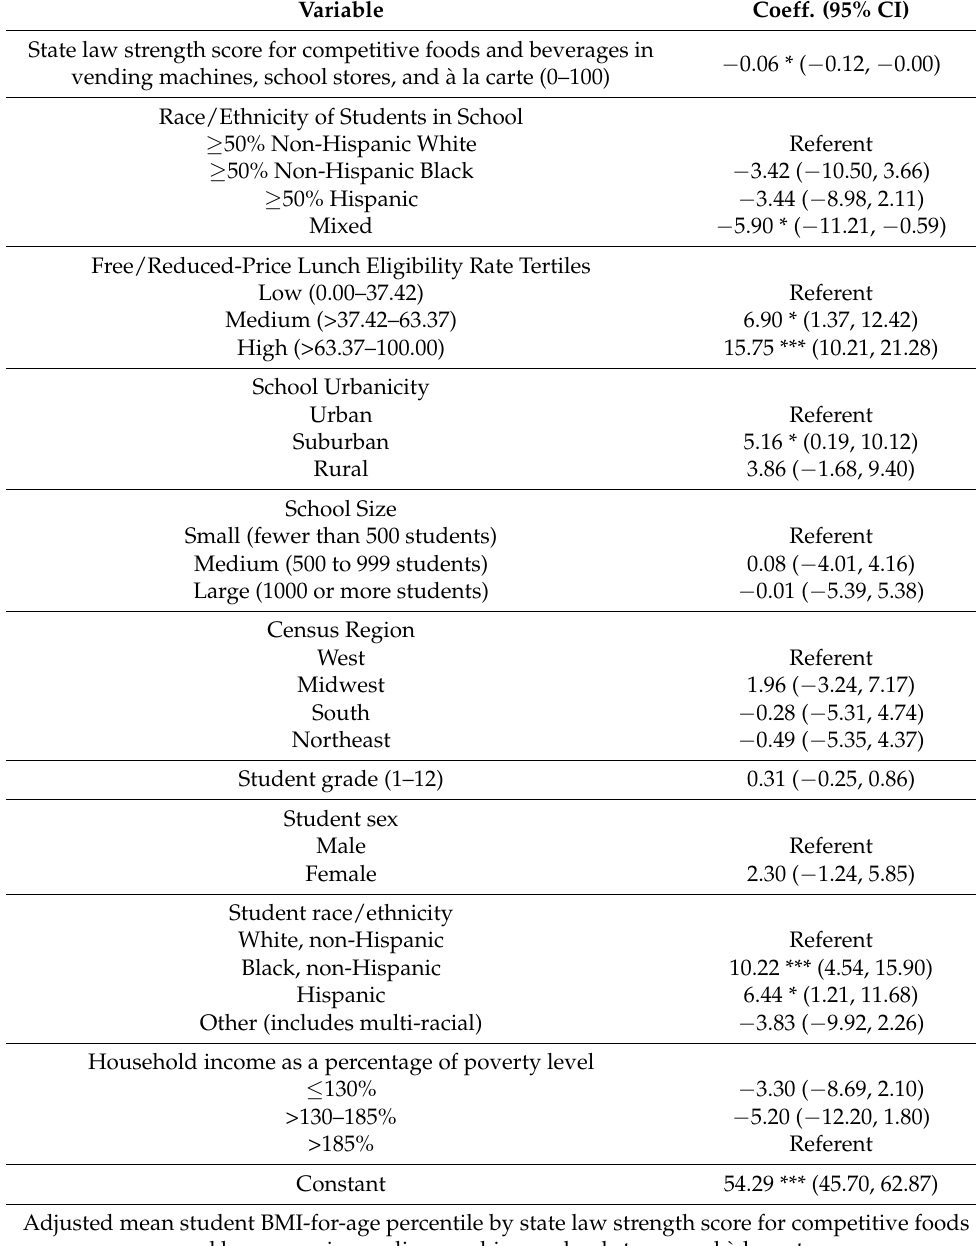
Table 2. Multivariable linear regression results for the association of state law and school and student characteristics with student BMI-for-age